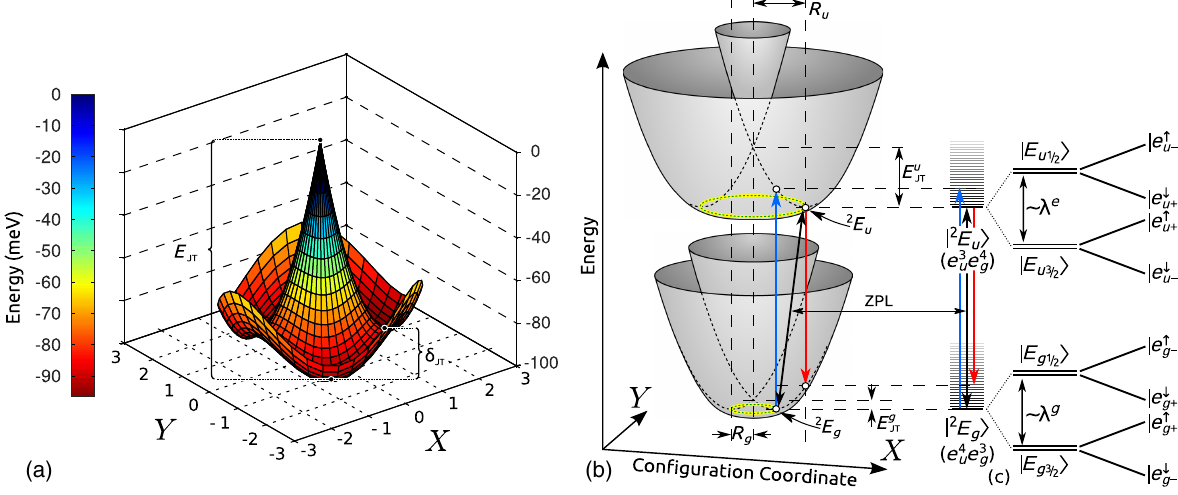
FIG. 3. (a) Jahn-Teller adiabatic potential energy surface (APES) of the optically excited 2 E state in PbV ð − Þ . (b) Jahn-Teller APES of u X V ð − Þ defects as a function of e and e phonon distortions, with quadratic JT effects neglected, which results in an APES with axial x y symmetry. In the ground state ( g ), the global APES minimum can be found at R distance ( C 2 distortion) from the high-symmetry D 3 g h d geometry while this is R for the u excited state. E , the Jahn-Teller energy, is the energy difference between the D 3 and C 2 u d h JT configurations. The δ energy barrier between the three local minima of C 2 configurations (few meVs) is not shown here for the sake of h JT clarity. In (c), we schematically depict the phonon sideband of the ground and excited state where blue (red) lines represent the excitation (luminescence) of the system intothe phonon sideband, whereas the black line defines the zero-phonon line transition (ZPL). The spin-orbit coupling ( λ ) splits 2 E and 2 E ZPL states apart into E , E , E , E Kramers doublets, where 3 and 1 refer to an effective total angular 2 2 g u g 1 2 g 3 2 u 1 2 u 3 2 states under external static magnetic field. momentum of the electronic states. The doublets may further split into individual e ↑ = ↓ g;u (cid:2)